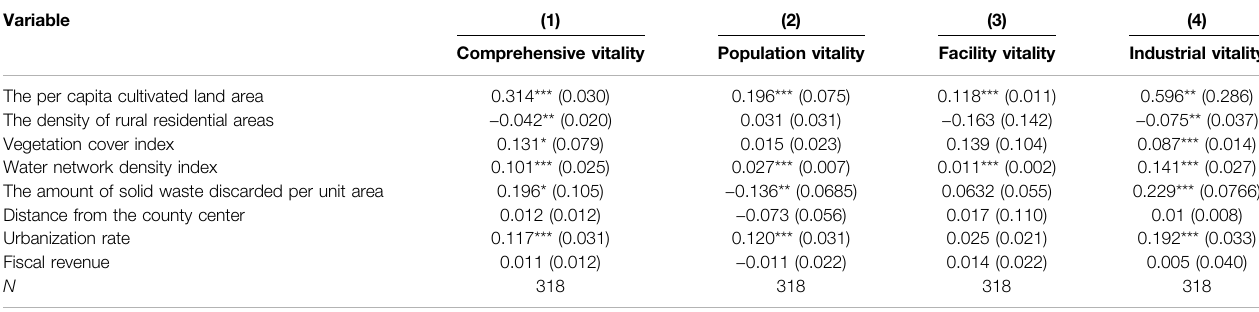
TABLE 4 | Resource and environment constraints of rural vitality.